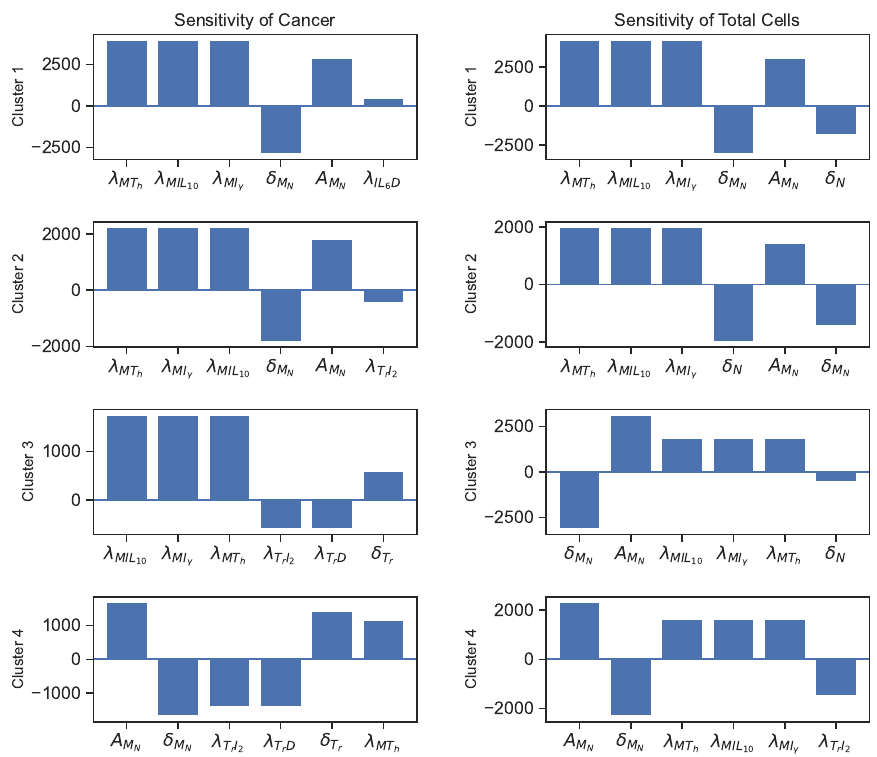
Figure 5. More sensitivity analysis results for cancer and total